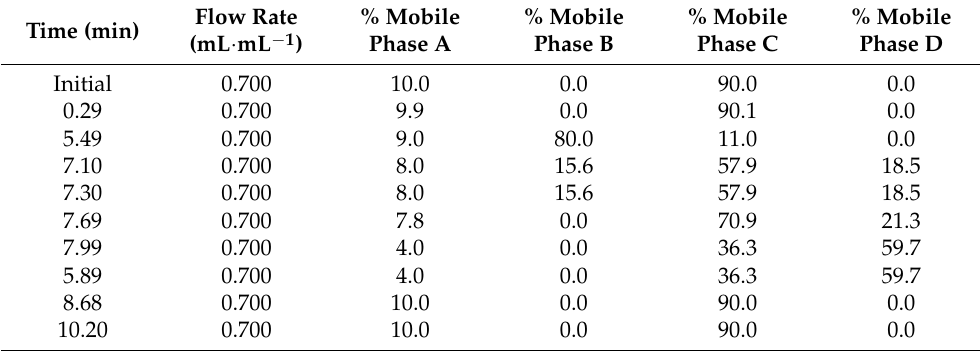
Table 1. Mobile phase composition for amino acids